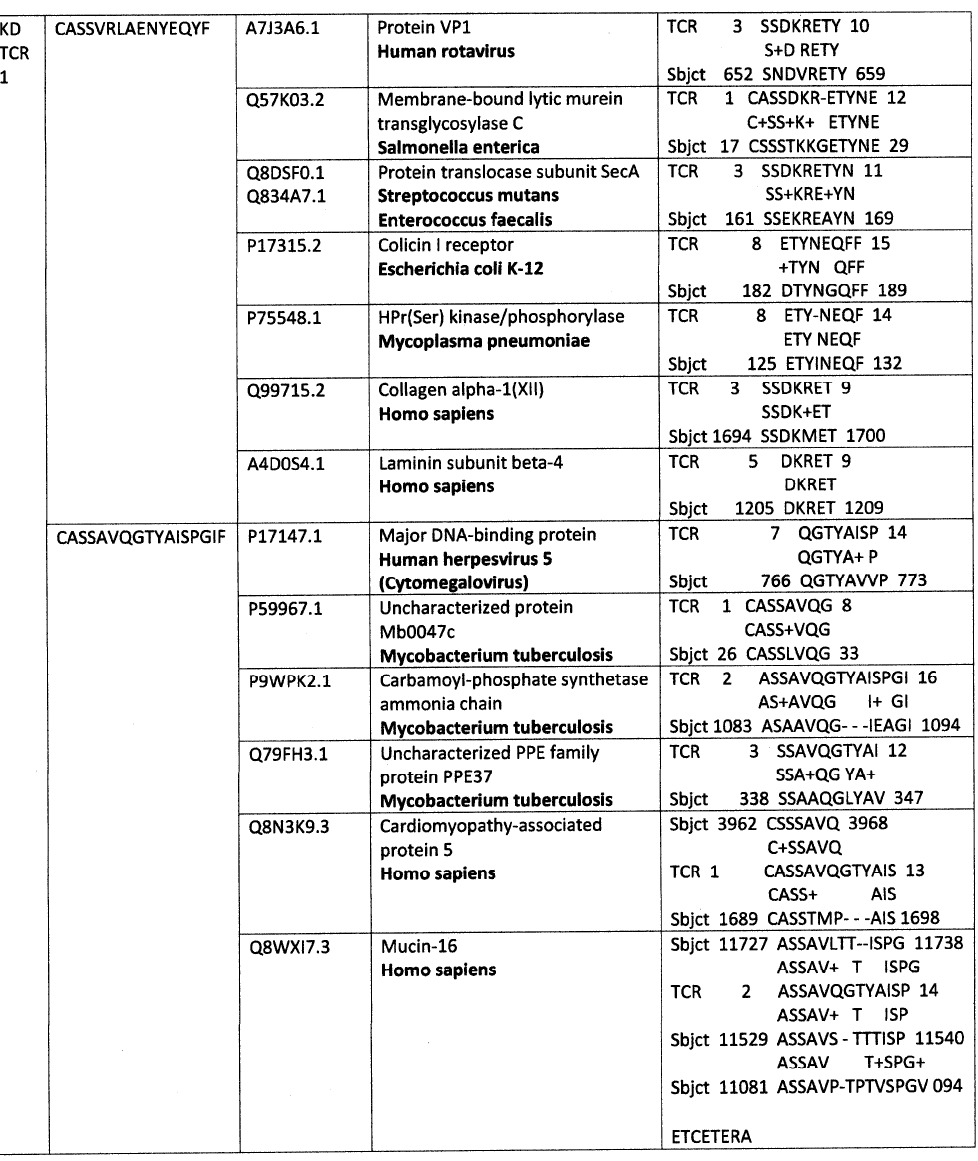
Figure 8. Selected TCR sequences from a Kawasaki disease (KD) patient number 1 [80] and their similarities to viral, bacterial and human proteins found by BLAST. Not only does each TCR sequence mimic a virus, bacterium and/or human protein, the figure also illustrates that many of these viral, bacterial and human proteins mimic each other. Additionally, the specific human proteins identified by this analysis correspond with well-known targets of autoimmune processes associated with MIS-C, including cardiomyopathies (myosins) and coagulopathies (von Willebrand Factor, fibrinogen and plasmin). Numbers in the second column from the left are the UNIPROT identifiers. Additional individual KD TCR mimicry examples are available in Appendix B.